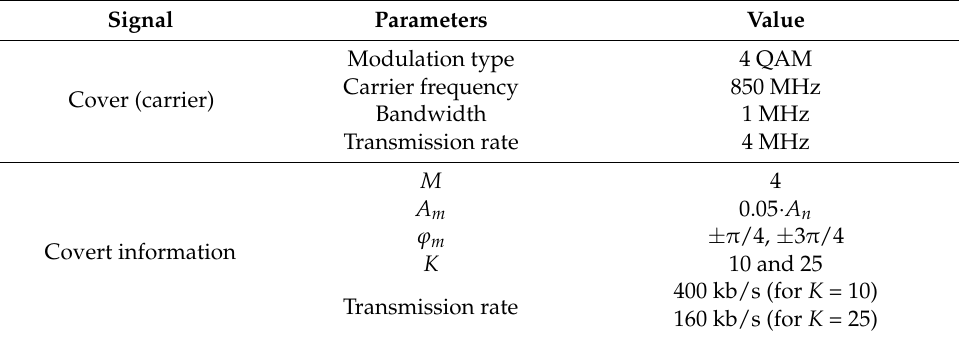
Figure 17. Test-bed based on USRP-2920 used for practical verification. Table 2. Parameters of radio signal.